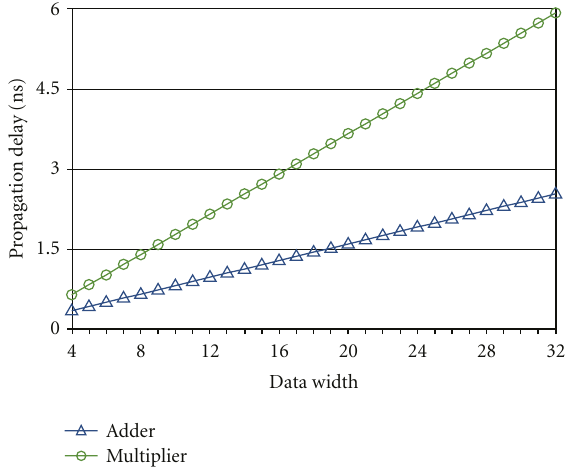
Figure 1: Delay for 32-bit resources (65nm ASIC).